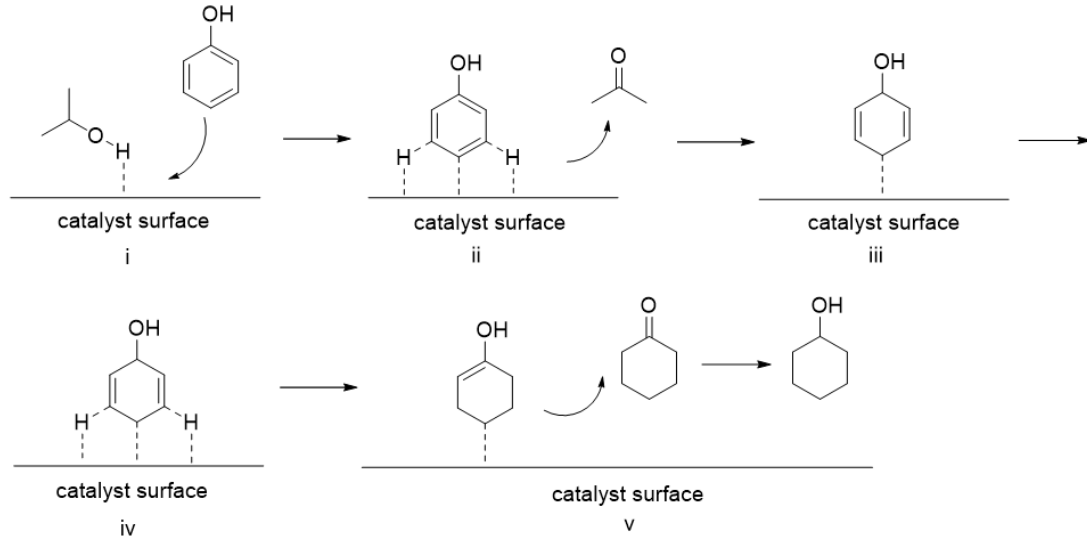
Figure 6. Catalytic pathway in the transfer hydrogenation of phenol.